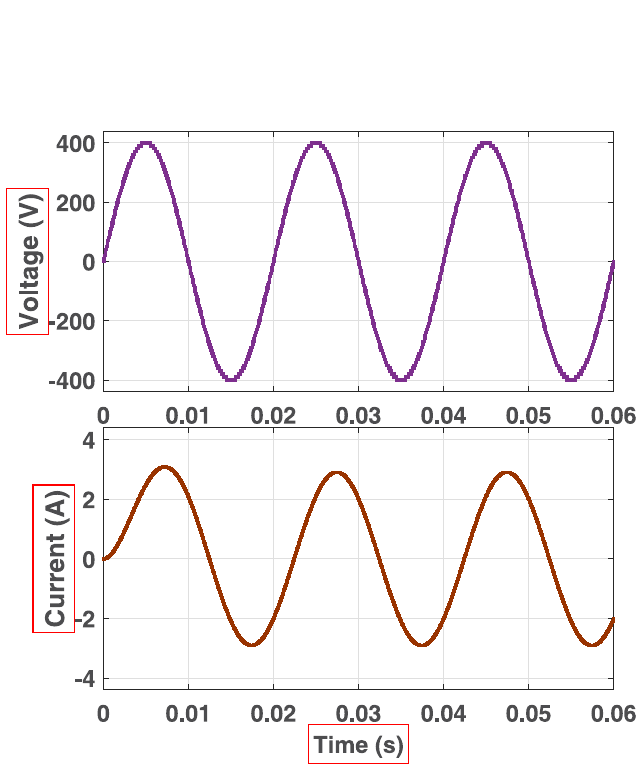
Fig 17. Simulation waveforms (voltage and current) at the output of 81-level MWMLI for RL-load.